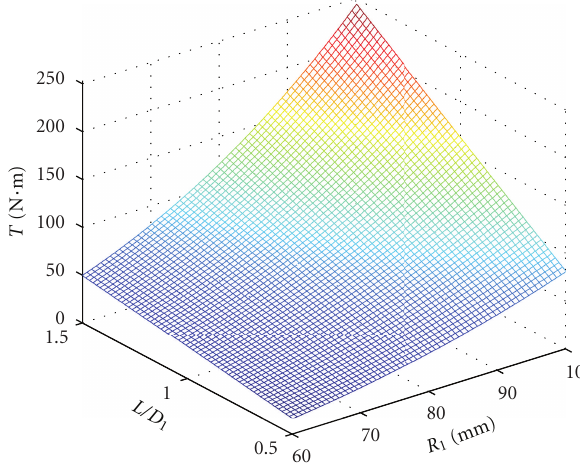
Figure 8: Torque versus breadth-diameter ratio l and inner radius R 1 .